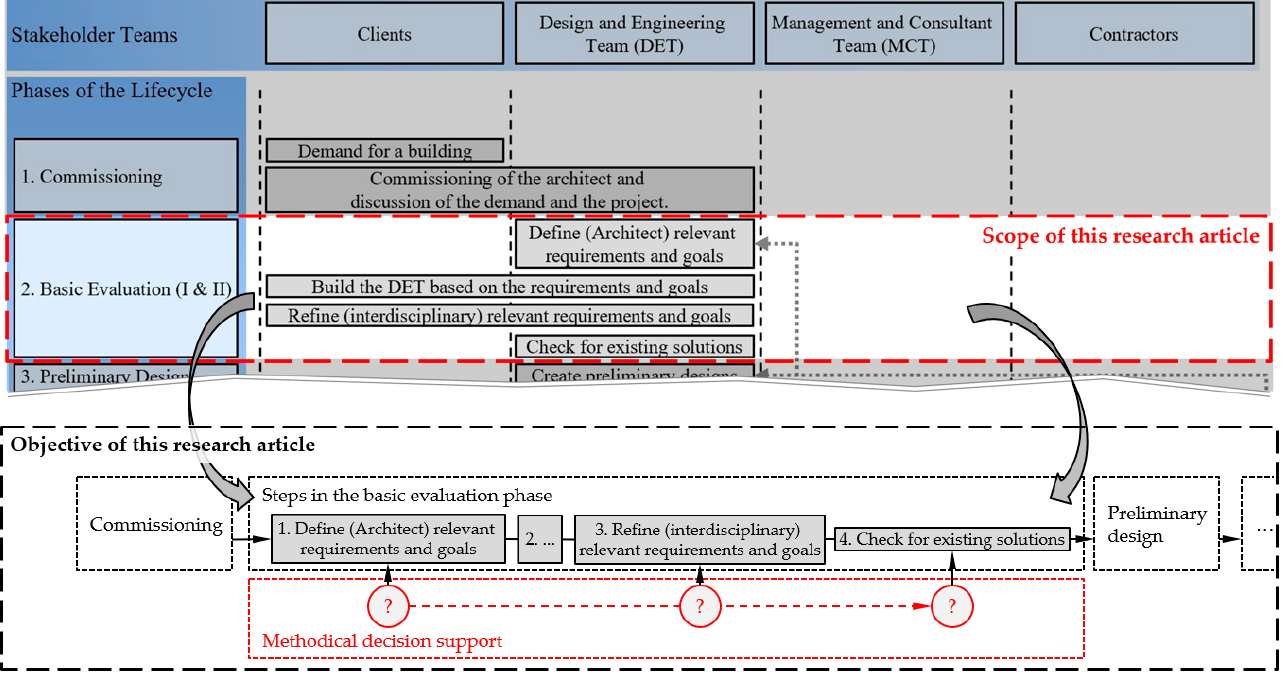
Figure 1. Excerpt of the early lifecycle phases of the integrated design framework by Voigt et al. [12], scope, and objective of this article—question marks indicate the search for suitable methodical support.